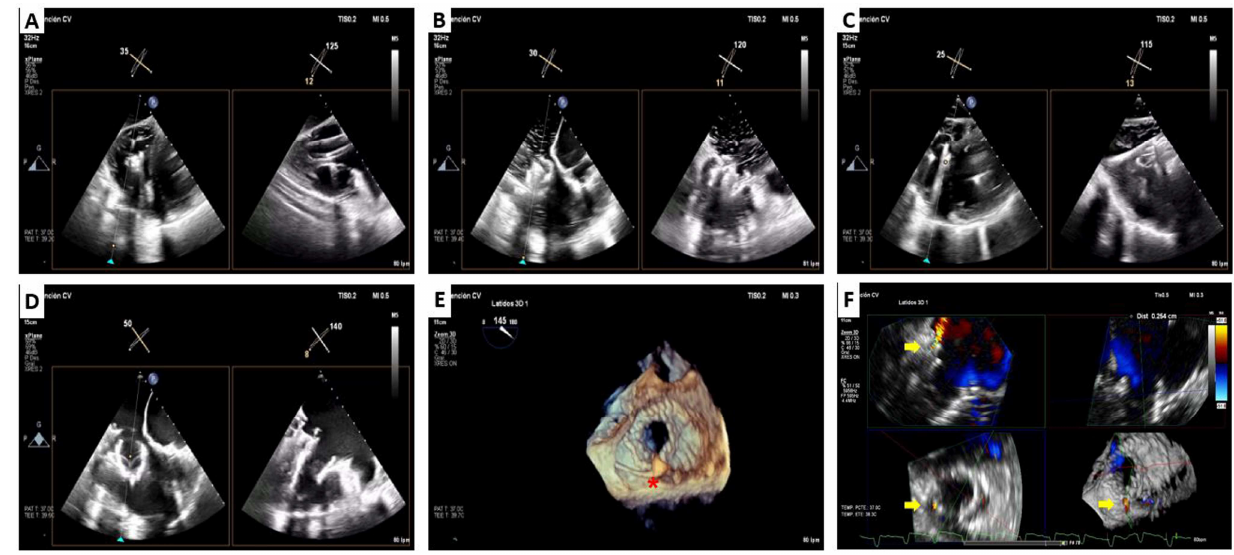
Figure 8. LuX-Valve Plus case. Transesophageal echocardiography procedural monitoring. Delivery system was placed perpendicular to the annular plane in a central position ( A ). The valve stent and the two anterior leaflet graspers ( B ) were withdrawn gradually. After confirming a satisfactory position, the anchoring system was released ( C ). Result: functionally and well-positioned valve ( D ), with the ICD lead placed into the posteroseptal commissure (( E ), red star) and a mild paravalvular leak on this position (( F ), yellow arrow).